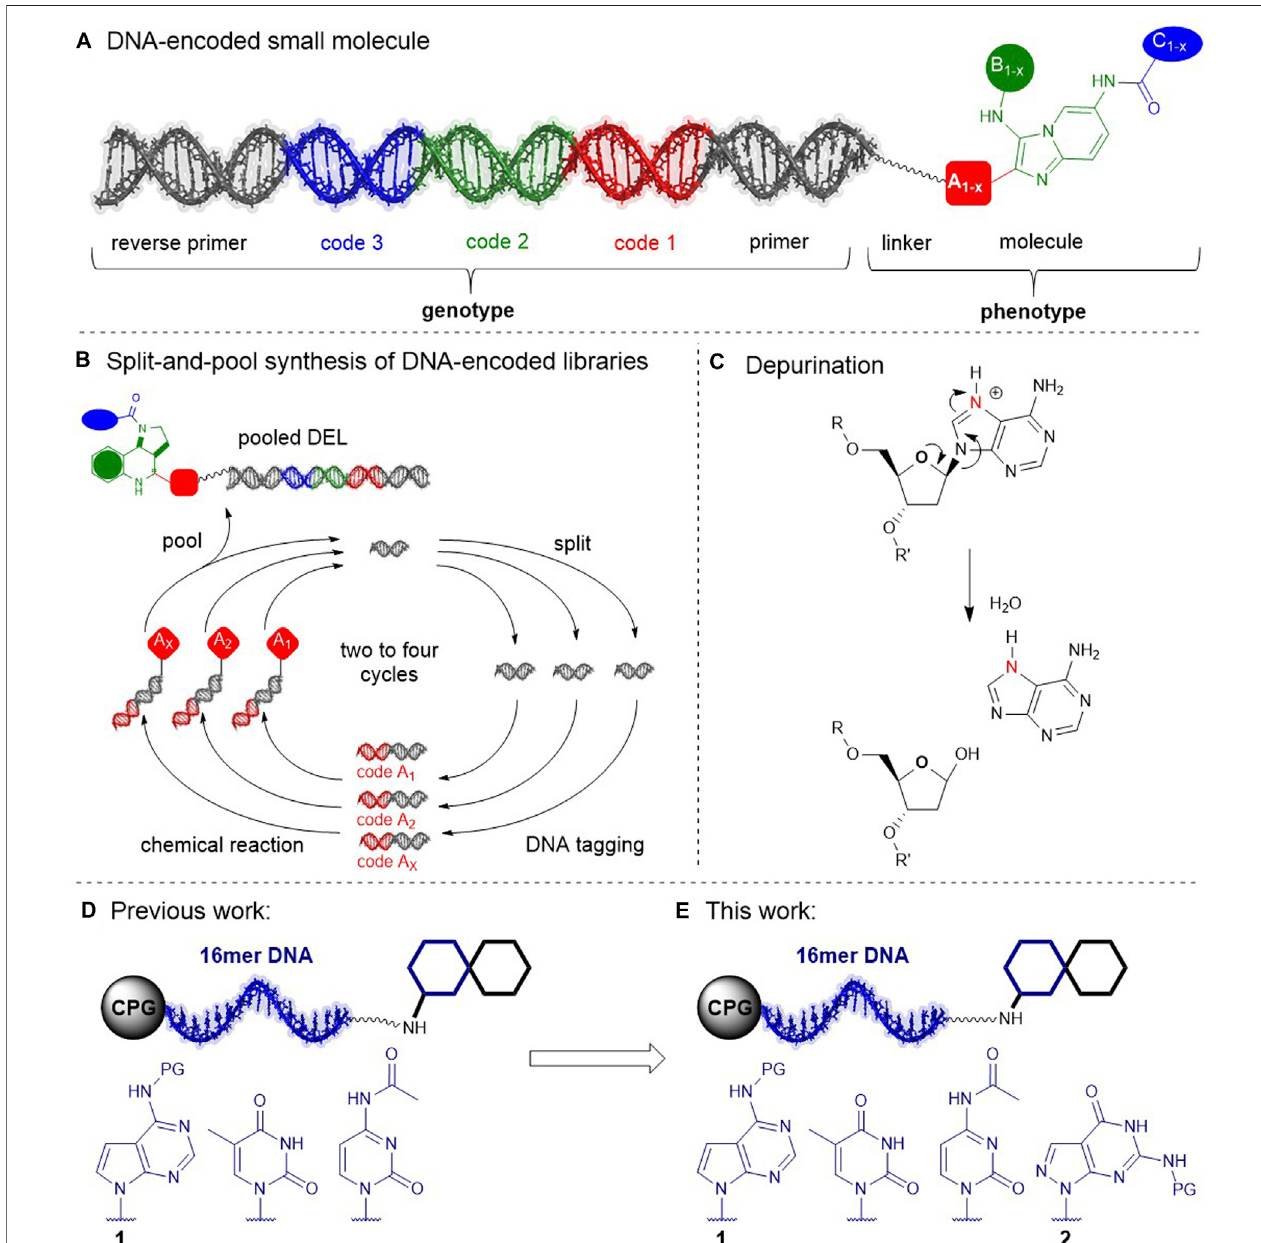
FIGURE1| DNA-encodedlibraries. (A) ADNA-encodedcompound. (B) Split-and-poolDELsynthesis (C) DNAdamagebydepurination. (D) Previouswork:Study ofachemicallystabilizedcodeconsistingofnucleobasesT,C,and7-deazaA 1 . (E) Thiswork:Fromathree-toafour-letterbarcode.Investigationof8a-7-deazaG 2 ;PG, protective group: benzoyl ( 1 ) or DMF ( 2